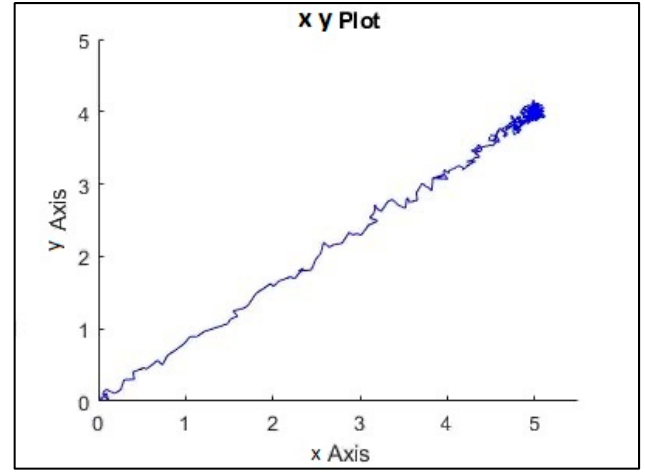
Figure 6. System with LQG controller control results with waves, positions (x,y).